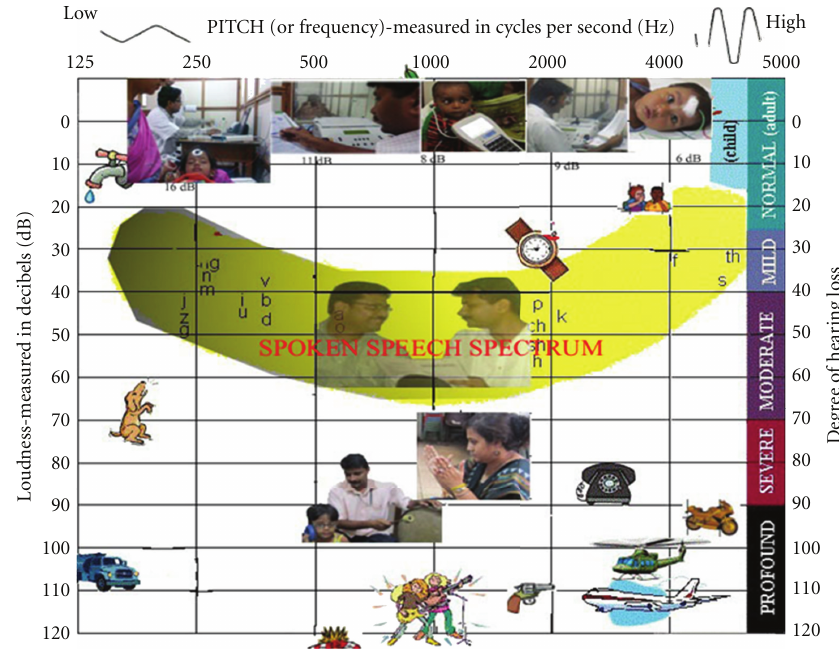
Figure 3: Depicting the sound intensities of common sounds along with the degree of hearing impairment. It also depicts Maximum Permissible Ambient Noise Levels (in dB re: 20 micro pascals) inside an audiometric test chamber ventilation fan